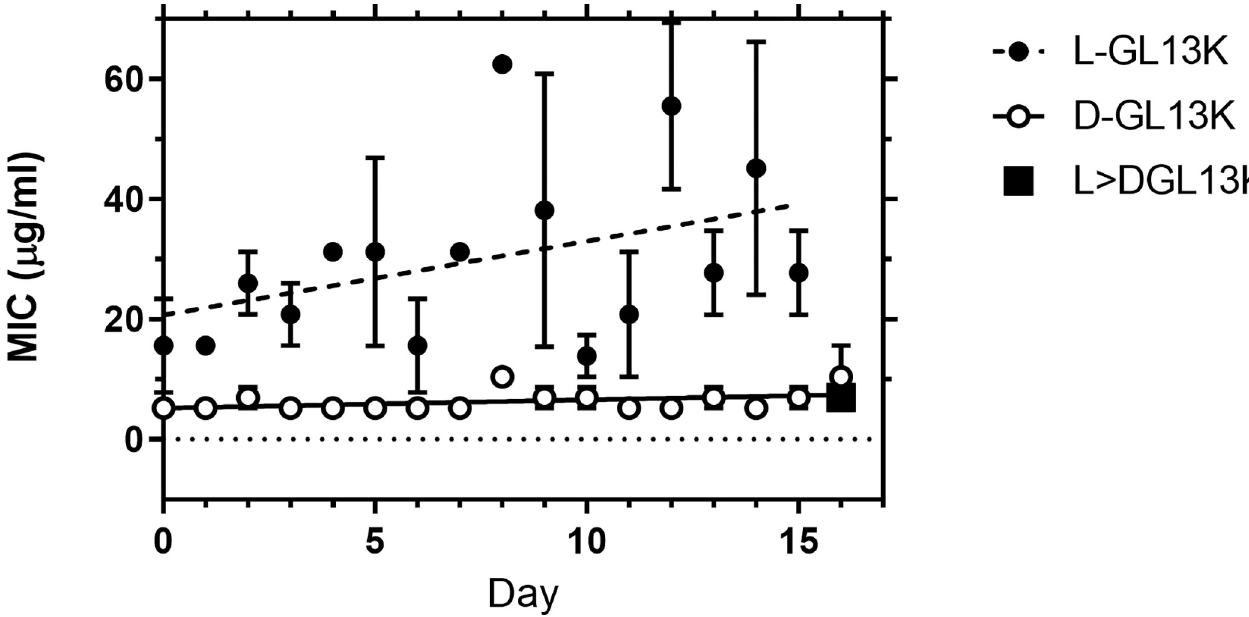
Fig 4. Development of resistance in P . aeruginosa by repeated treatment with LGL13K (closed circles) or DGL13K (open circles). The MIC determinations were plotted for each day (mean ± SEM, N = 3) and analyzed by linear regression. Samples treated with LGL13K for 15 days were then treated with DGL13K and the MIC determined (square. Mean ± SEM, N =